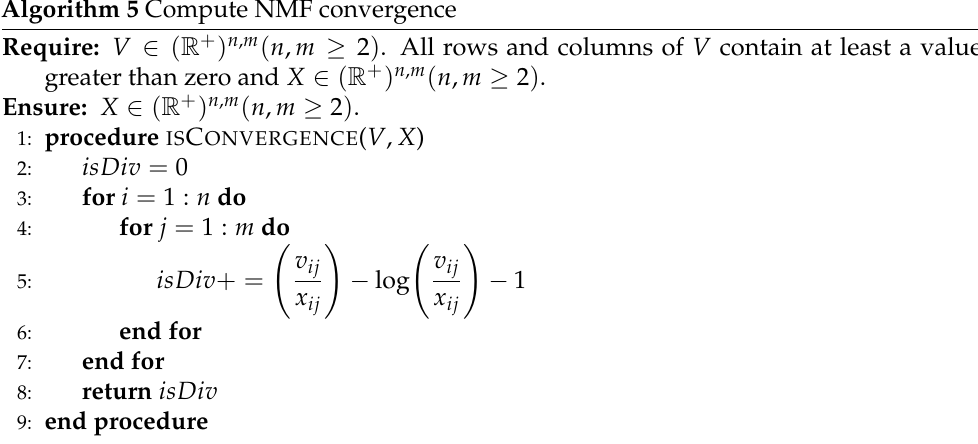
Algorithm 5 Compute NMF